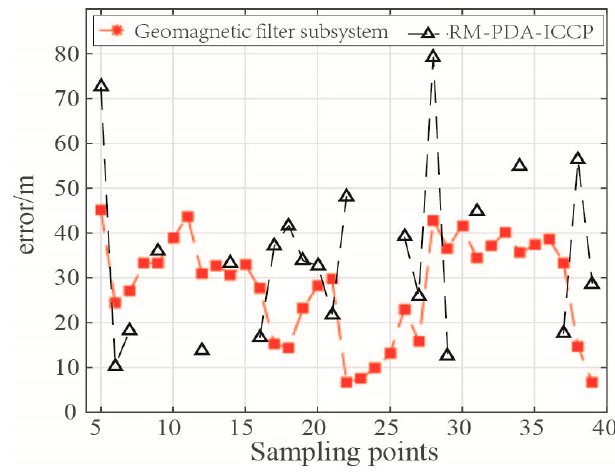
Figure 13. Geomagnetic filtering result. ( a ) Filtering results of the geomagnetic filter subsystem; ( b ) The magnetic values along the trajectory.